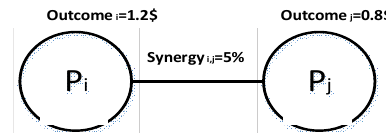
Fig. 4. Graphical view of projects interactions caused by market interdependency